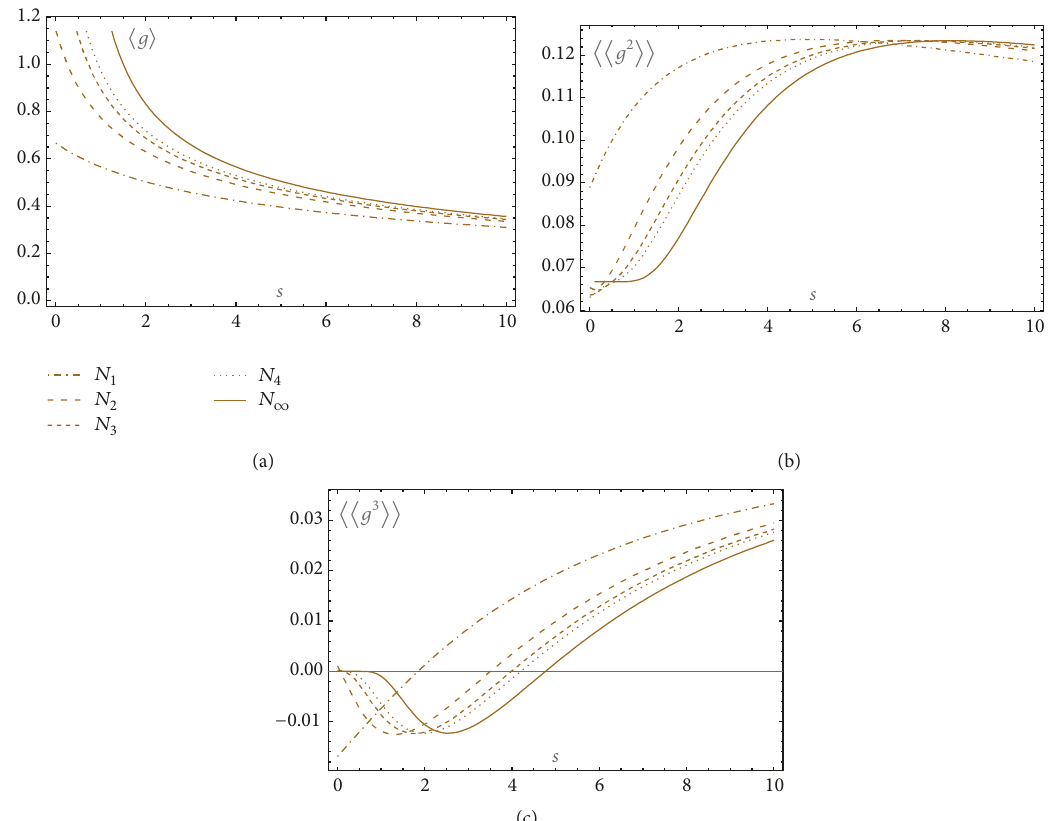
Figure 3: Variation of the first three cumulants of the thermal conductance for the DIII class with different numbers of channels 𝑁 . 𝑁 1 = 𝑁 = 𝑁 2